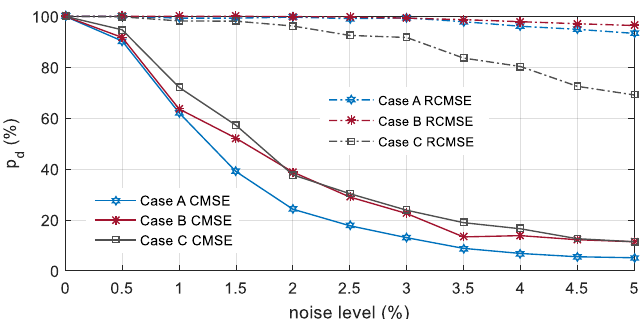
Figure 15. The identification probability of damage cases A to C against the level of noise.